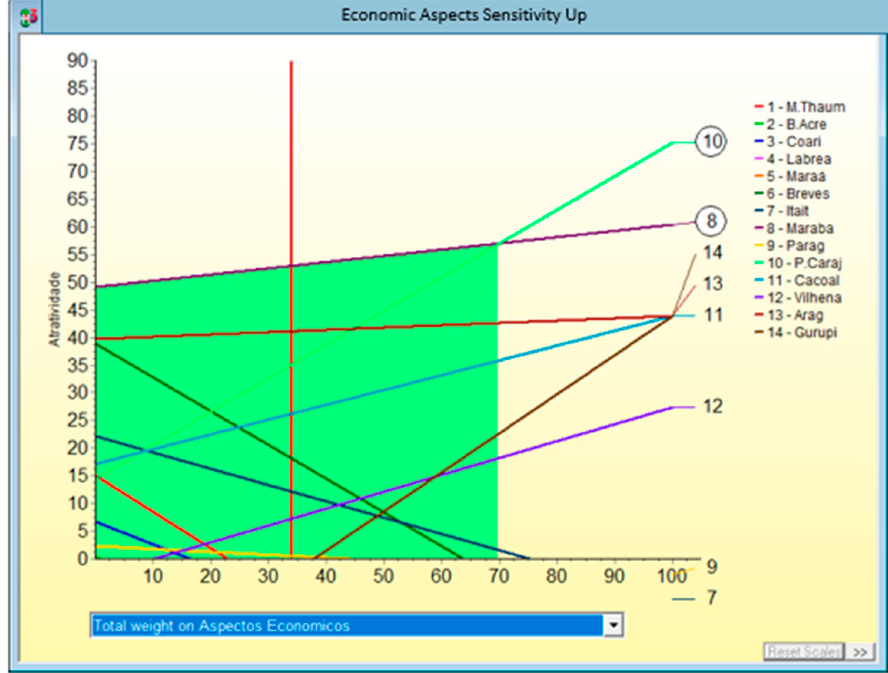
Figure 5. FPV 2 sensitivity